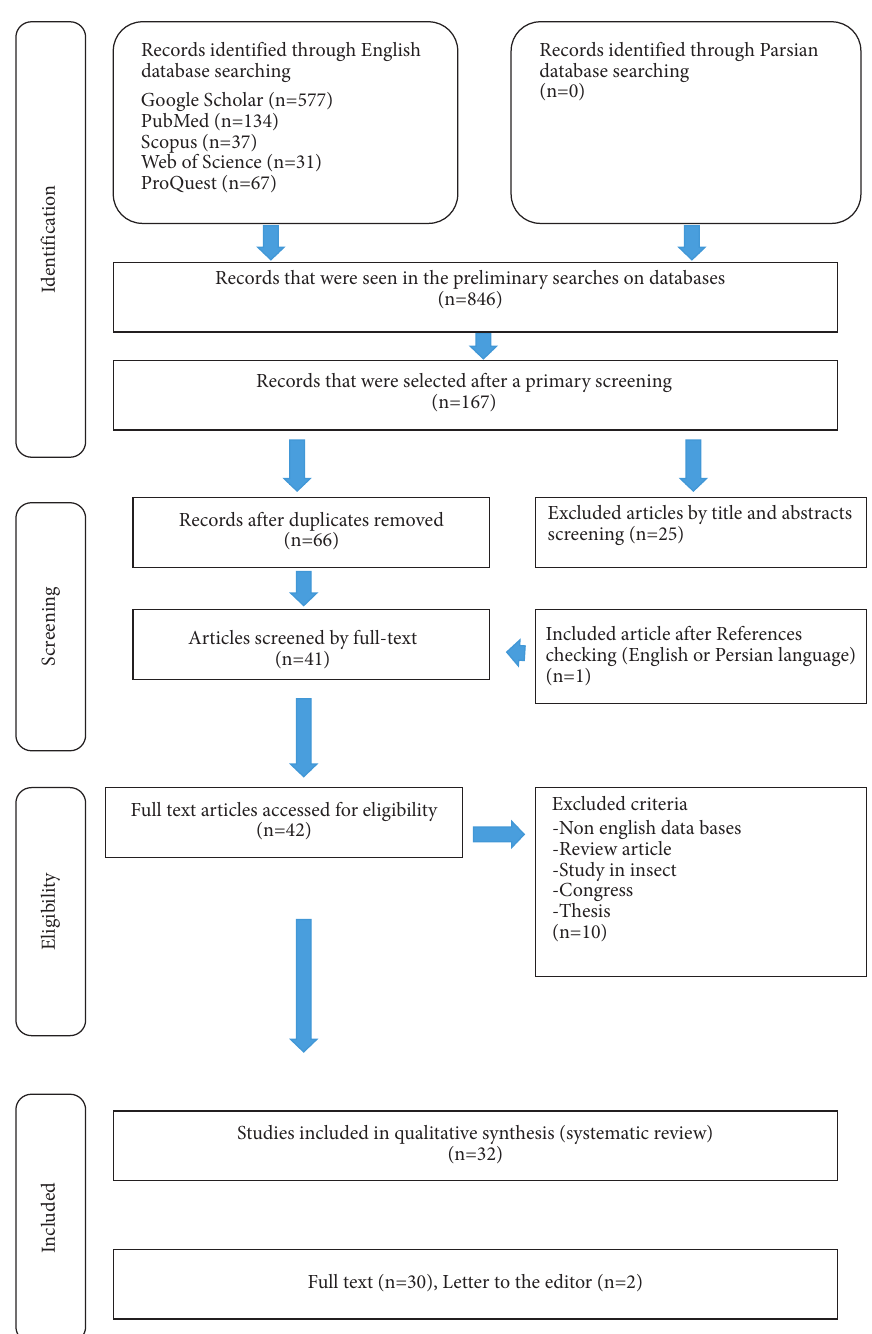
Figure 1: Flow diagram of the study design